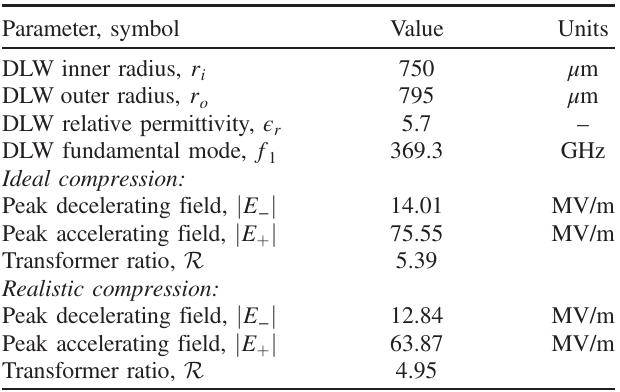
resulting wakefield values using the current profile shown in Fig 9. The “ ideal- ” and “ realistic-compression ” entries respec- tively correspond to the cases when the final current profile is obtained via a simple longitudinal-axis scaling or via particle tracking.